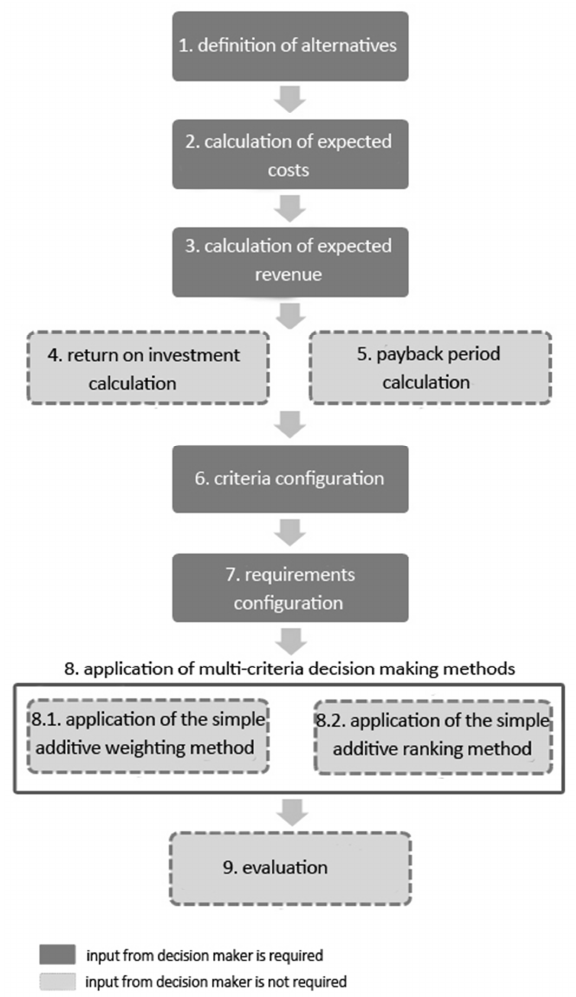
Figure 1 – Proposed methodology for decision